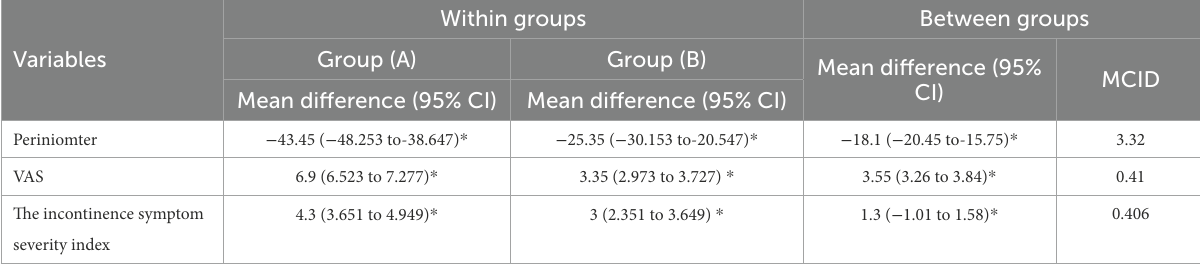
TABLE 4 Within and between groups differences at 95% CI for the effects of